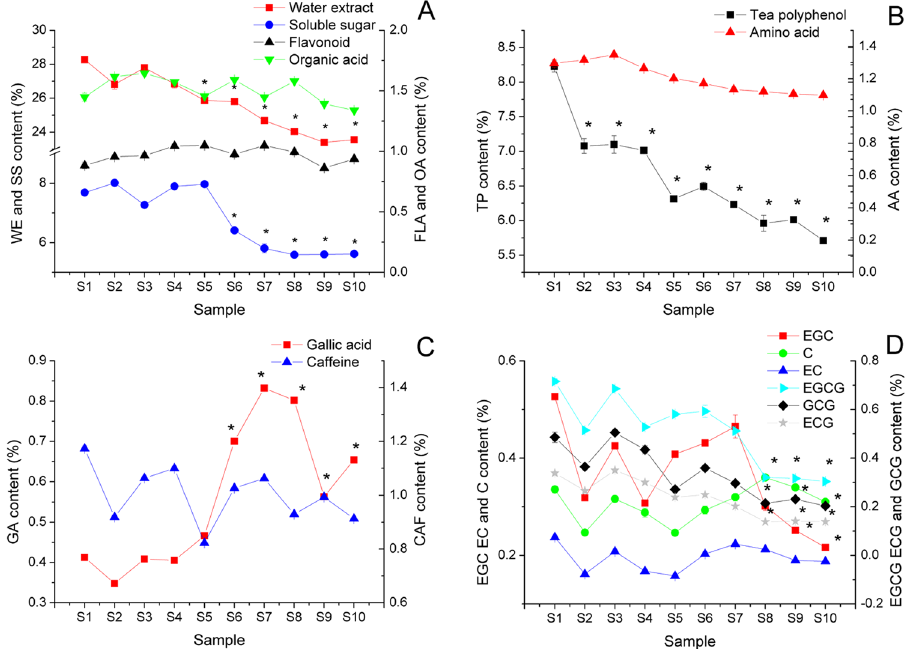
Figure 1. Metabolite changes during manufacturing process of Fu brick tea. water extract (WE), soluble sugar (SS), flavonoid (FLA), organic acid (OA), tea polyphenol (TP), amino acid (AA), gallic acid (GA), caffeine (CAF), epigallocatechin gallate (EGCG), epigallocatechin (EGC), epicatechin gallate (ECG), gallocatechin gallate (GCG), epicatechin (EC), catechins (C). * Indicated that the significance < 0.05, compared with S1; ** indicated that the significance < 0.01, compared with